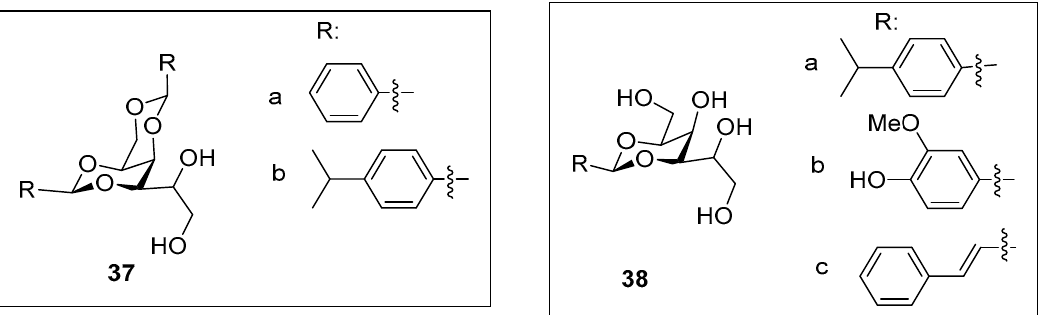
Figure 27. Structures of sorbitol diacetals 37 and monoacetals 38 [74]. McNeice et al. found three sugar-based LMWGs capable of forming gels in ionic liquids and the structures are depicted in Figure 28 [75]. A total of 21 different ionic liquid gels were achieved using these gelators. These include imidazolium, pyridinium, phospho- nium and ammonium-based ionic liquid gels. They explored the role of hydrogen bonding and steric effects in self-assembly when varying the cationic and anionic components of the ionic liquids. The larger the size of the cationic component, the larger the amount of gelator required for gels to form. Bulky ionic liquids were found to disrupt gelation in comparison to ionic liquids that contain a single alkyl chain. This study also found that ionic liquids with strong hydrogen bond donating and accepting components did not prevent gelation, indicating a strong interaction between each other rather than interfering with gelator self-assembly. While all three gelators successfully formed gels in ionic liquids, gelator 40a formed gels in almost all of the ionic liquids tested. Expectedly, the ionic liquid gels showed higher thermal stability compared to the ionic liquids themselves. Reversible ionic liquid gels such as these have potential uses in various electrochemical applications.